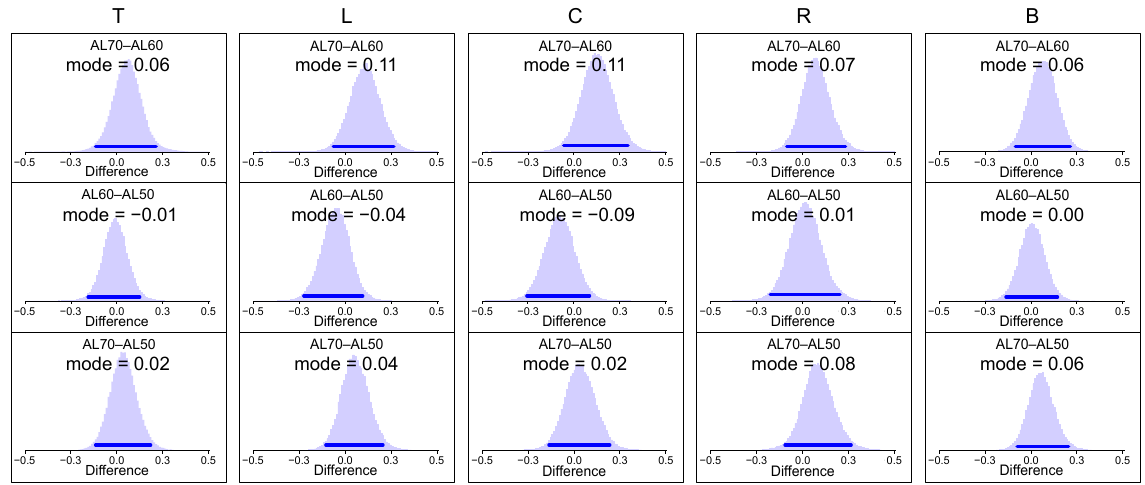
Figure 11. The results of the BEST analysis for the gaze positions for the ( a ) AL50, ( b ) AL60, and ( c ) AL70 conditions. Figure 12 shows the comparison results for the image brightness conditions. If image brightness affects LRR TH , the distribution of the differences between AL70 and AL50 will be more skewed than for the other distributions. The obtained results, however, show that it did not affect it. The skew patterns were erratic, regardless of image brightness. Only one feature was commonly observed in all results, namely that the 95% HDI includes zero. The results clearly show that there was no significant correlation between LRR TH and image brightness. Because the experimental conditions were more strictly controlled in this study, as mentioned above, we suggest that LRR TH could be independent of image brightness.